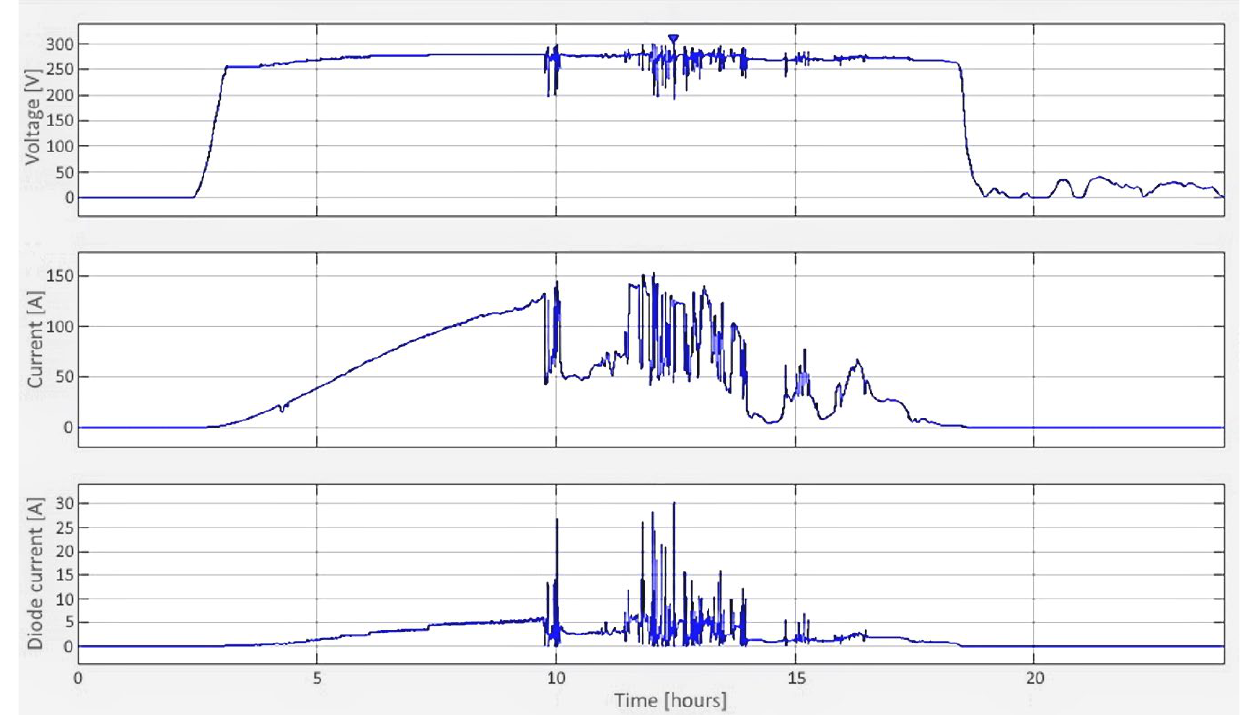
Figure 22. Daily waveforms of voltage and current of the PV modules (39.65 kW) and PV diode current on a sample day in July. Table 4. Values of voltage and current on PV modules (39.65 kW) and PV diode current on a sample day in July.